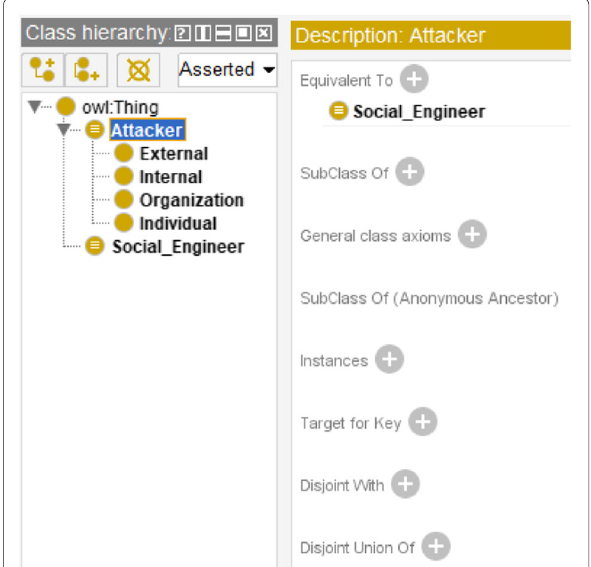
Fig. 2 Edit concepts and their